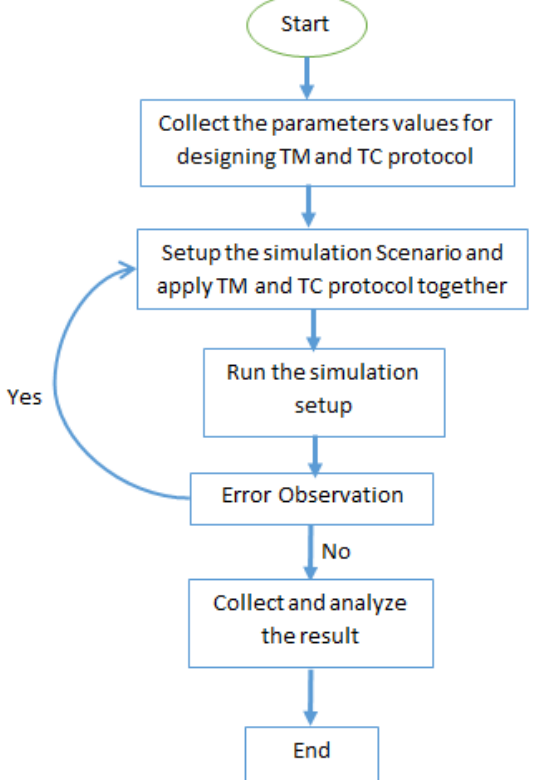
Figure 4. Steps involve in the designing process of the research